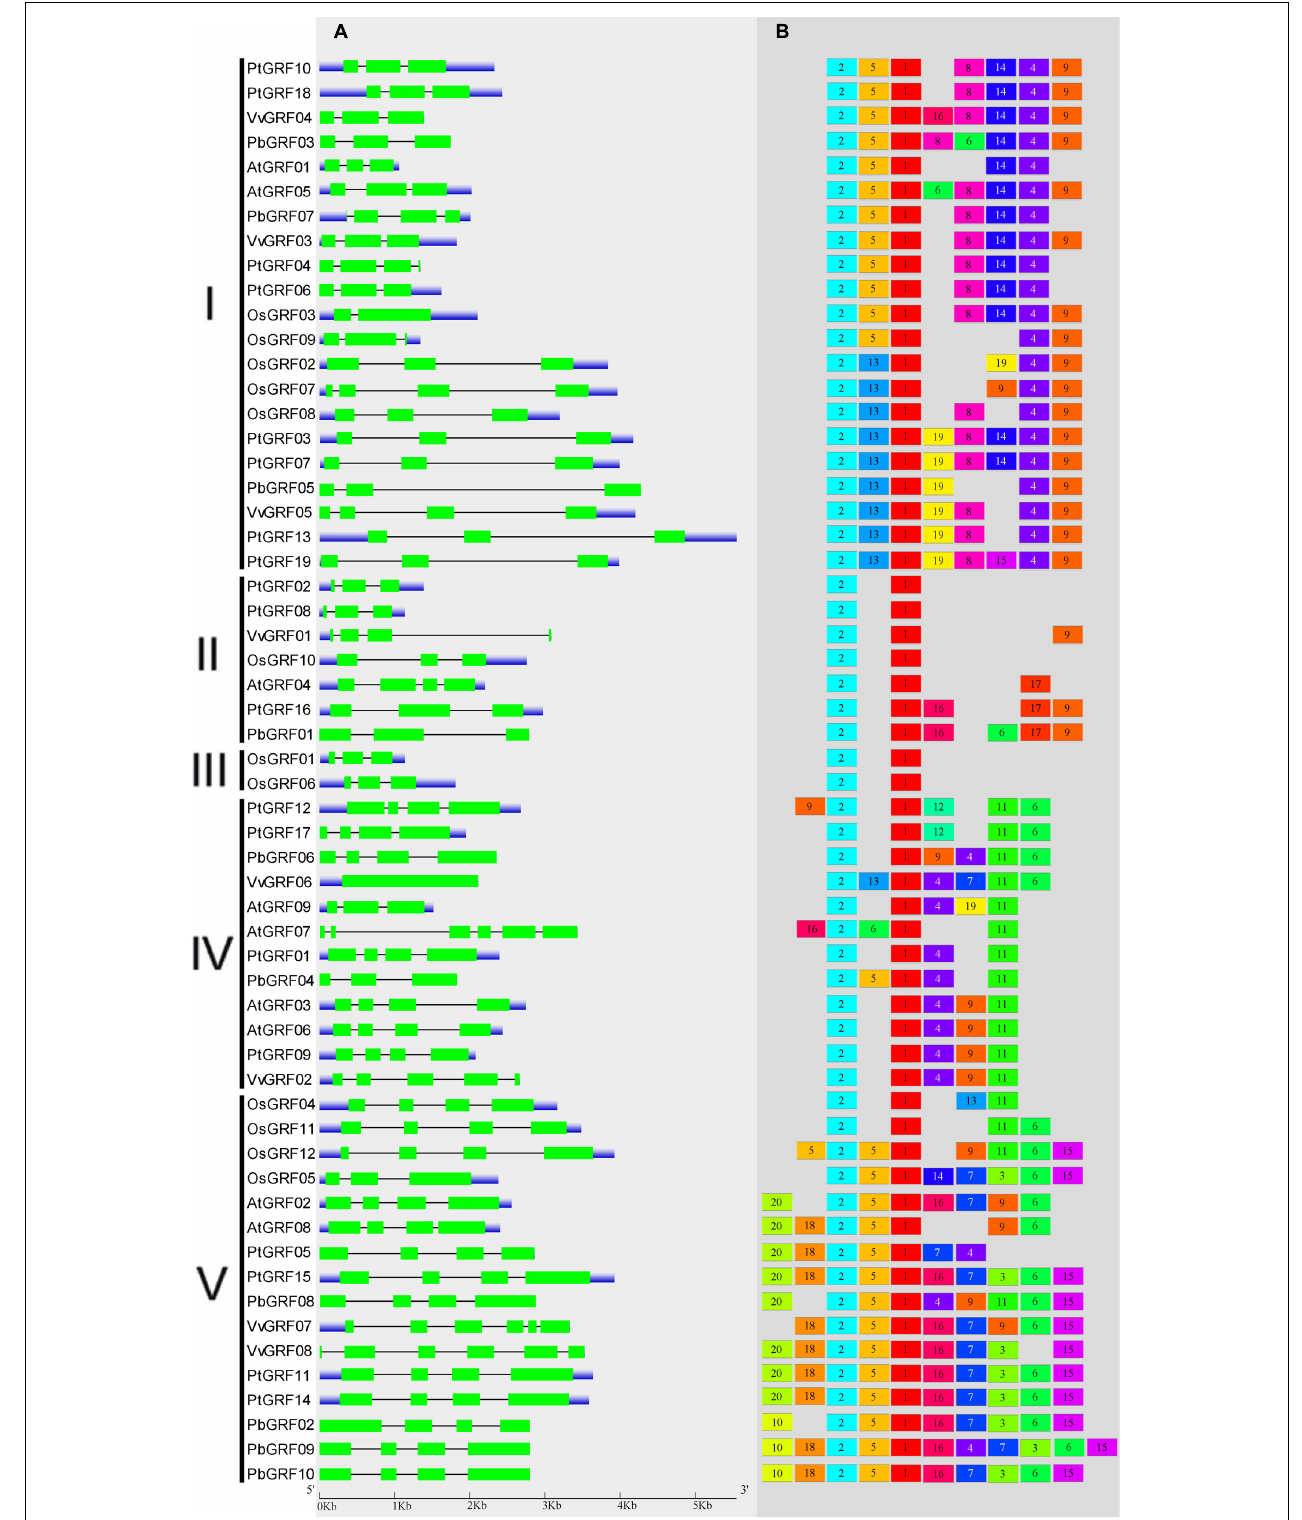
FIGURE 3 | Exon-intron structure and motif compositions of GRF genes across five plant species. (A) Exon-intron structures of the GRF genes. Green rectangles: exons; thin lines: introns; blue boxes: untranslated regions (UTRs). (B) MEME motif search results. Note that different motifs are represented by different color boxes and that the length of each box does not show the true motif